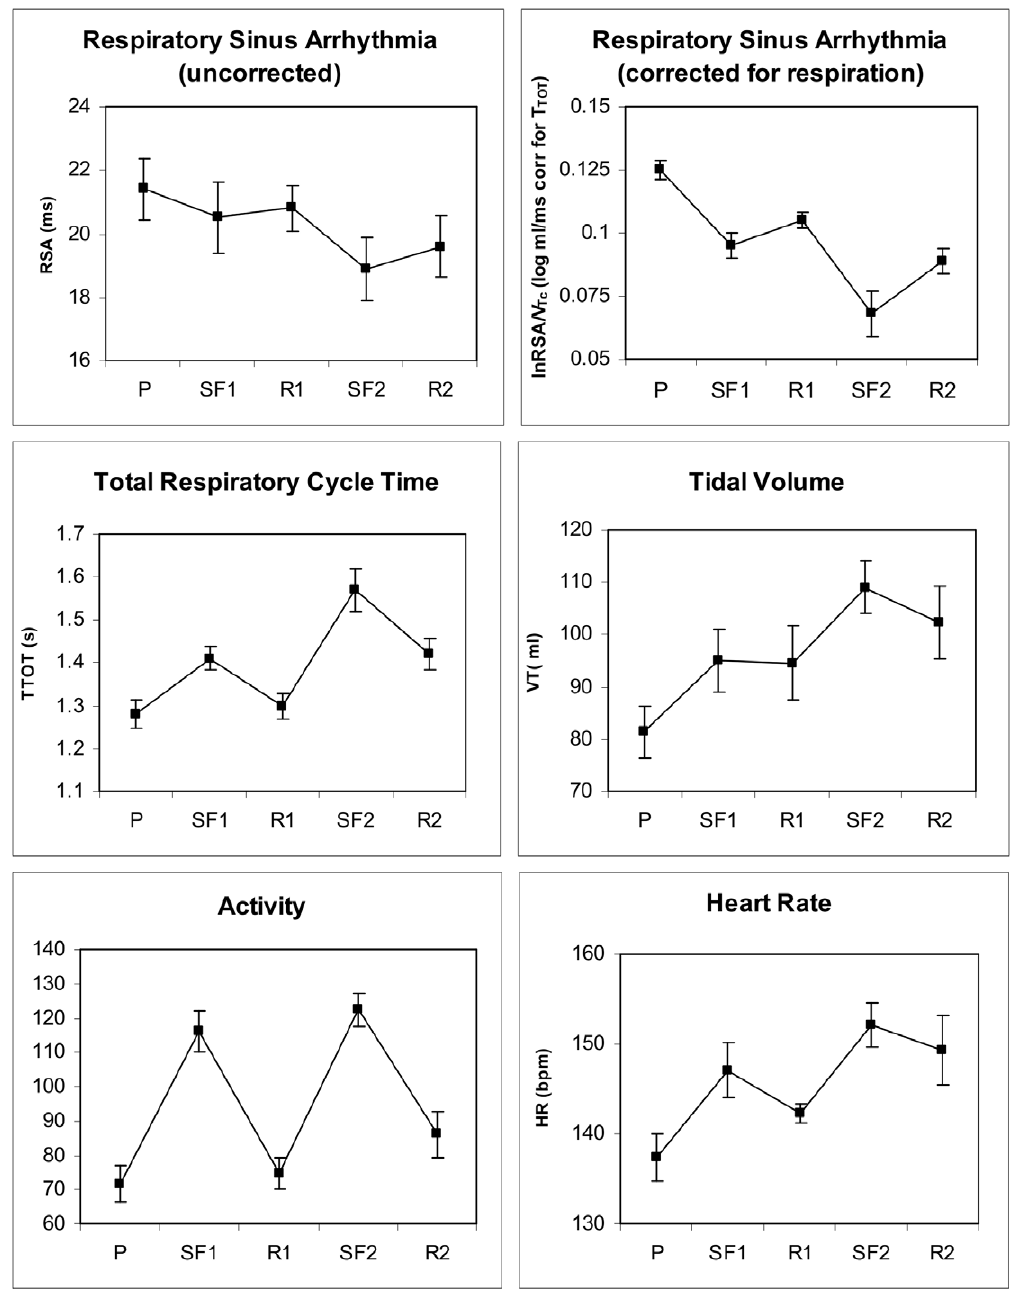
Figure 2. RSA (uncorrected and corrected for respiration), respiratory parameters, physical activity and heart rate across the two Still-Face Test challenges (n=16).